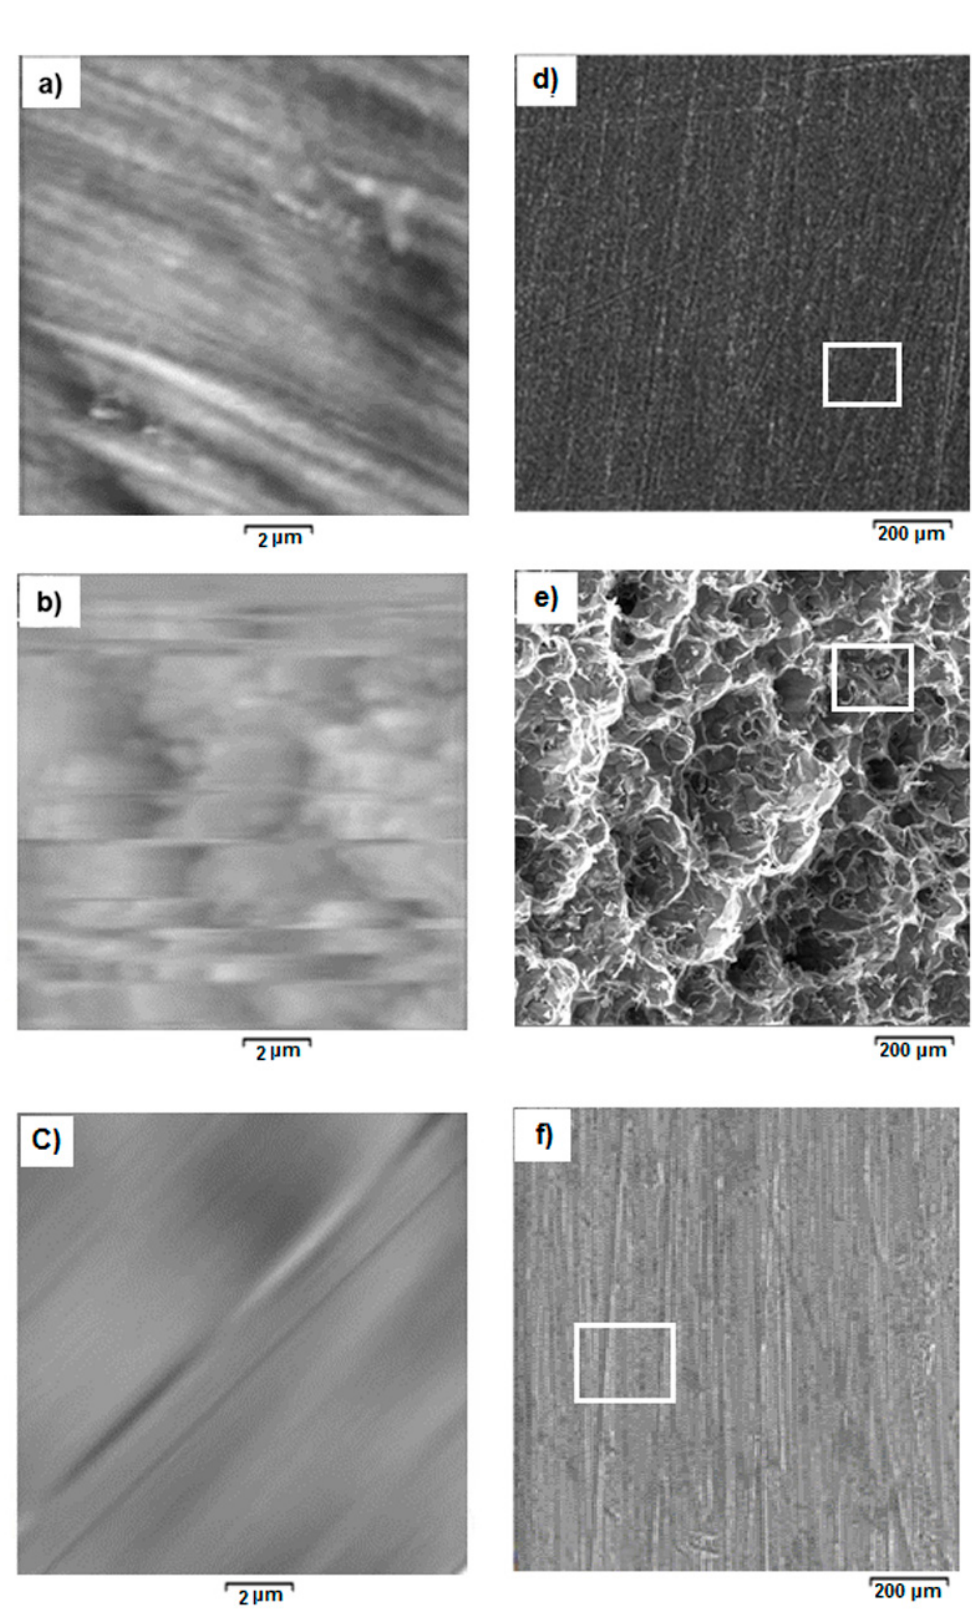
Figure 9. AFM surface topologies and SEM images of mild steel surfaces in 1 M HCl at 333 K: ( a , d ) polished before immersion, ( b , e ) immersion blank (uninhibited), and ( c , f ) immersion in the presence of 4.50 × 10 − 4 mol L − 1 corrosion inhibitor 7